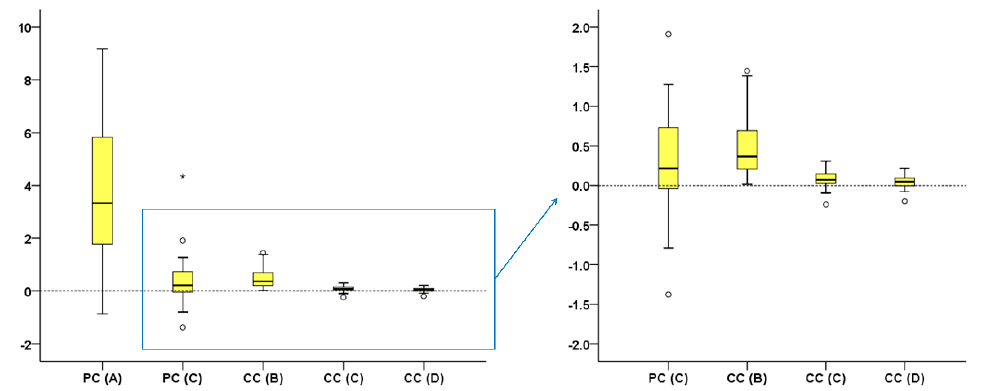
Figure 4. Difference of each technique from the gold standard technique in tooth wear assessment shown in box plots ( y -axis, mm 3 ). The upper limit of the black line represents the maximum value, the lower limit the minimum, the box the interquartile range, and the horizontal black line the median value (trueness). Outliers are shown as black circles (°) or asterisks (*), in more extreme cases, with a step of 1.5 × IQR (interquartile range). Zero value (dashed horizontal line) indicates perfect agreement with the gold standard. Precision is indicated by the vertical length of each plot. The blue box on the right image indicates the area of the graph shown in the left image in a larger scale.